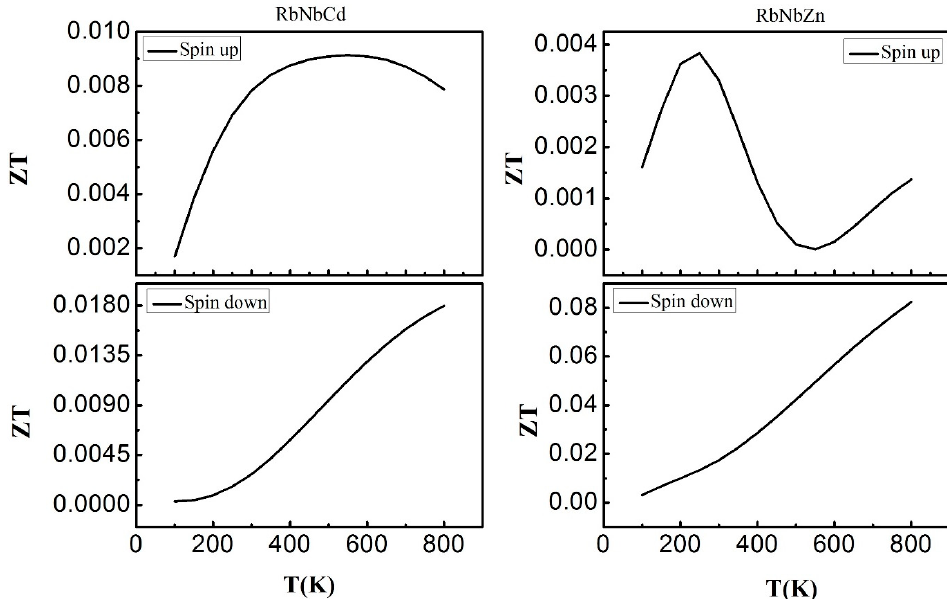
Figure 13. Temperature dependence of the figure of merit (ZT) for RbNbCd and